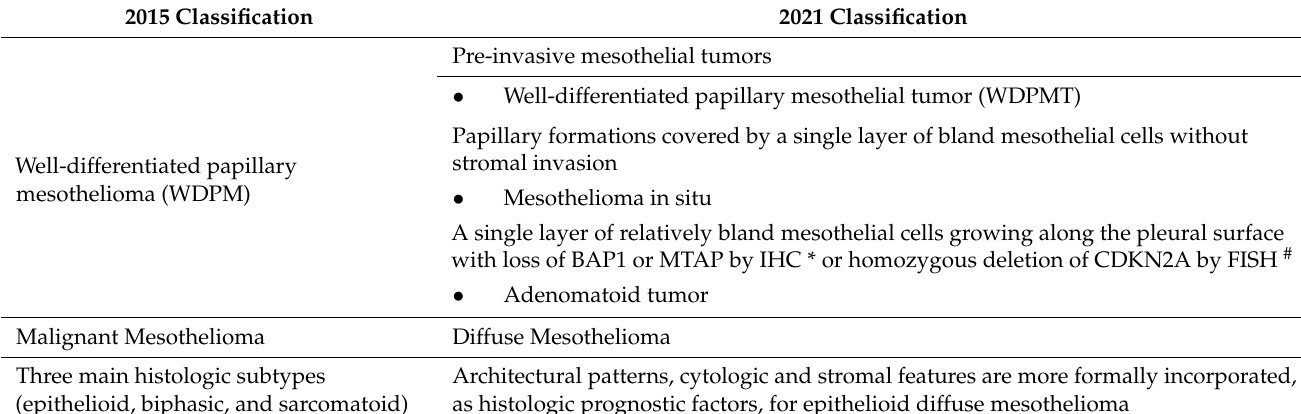
Table 1. Major changes in 2021 WHO Classification of Tumors of the